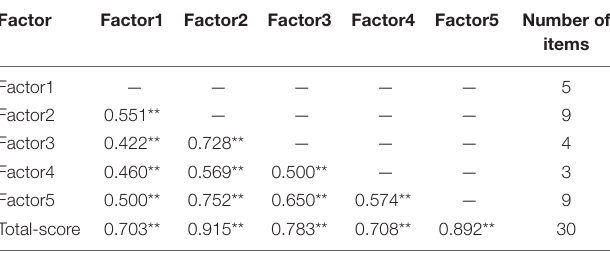
TABLE 6 | Correlations among factors in the Chinese Revision of the Pitt Wellness Scale ( N = 1870). Factor Factor1 Factor2 Factor3 Factor4 Factor5 Number of